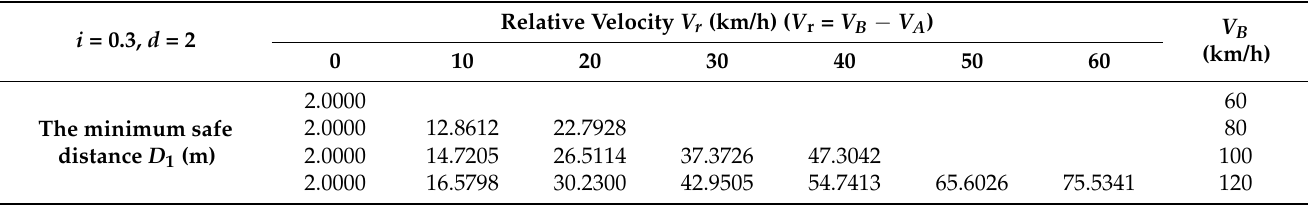
Figure 8. Changes in the sufficient safe distance D 3 with various V B and V r when i = 0.3 and d = 2. Table 5. The minimum safe distance D 1 based on V B between 60 and 120 km/h when i = 0.3 and d = 2.